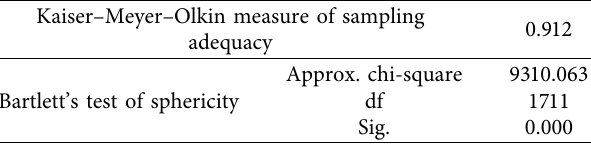
Table 5: KMO and Bartlett’s